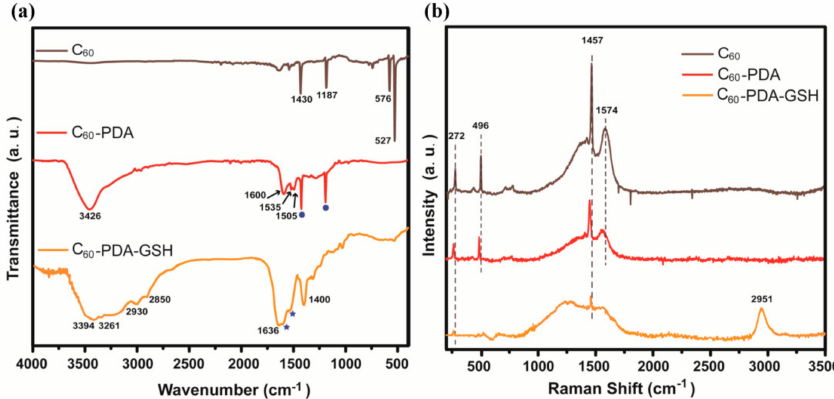
Figure 1. FTIR ( a ) and Raman spectra ( b ) of C 60 , C 60 -PDA and C 60 -PDA-GSH. The solid circles and asterisks label the signals from C 60 and PDA,